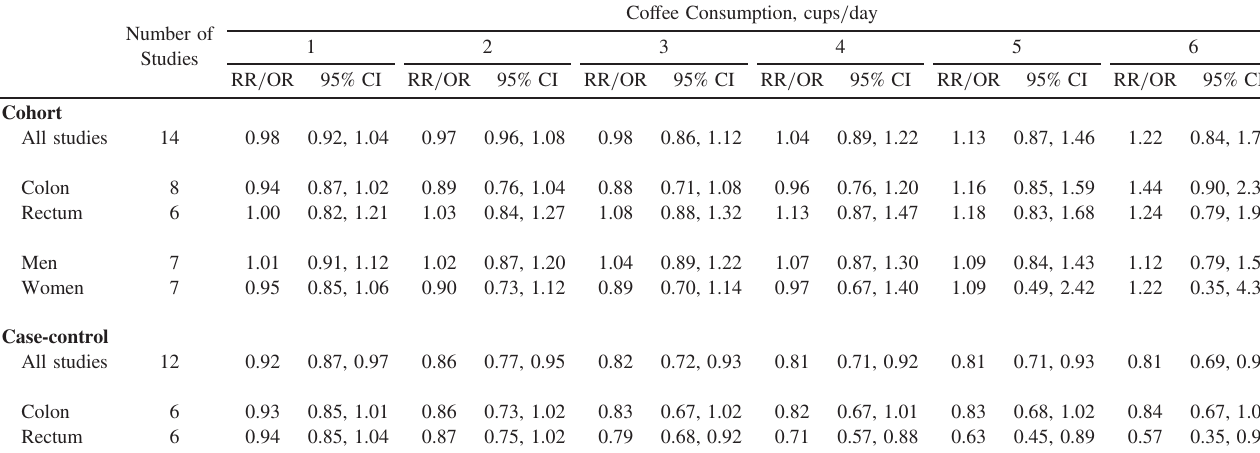
Table 3. Relative risks or odds ratios of colorectal cancer associated with consumption of 1 – 6 cups of co ff ee per day Number of